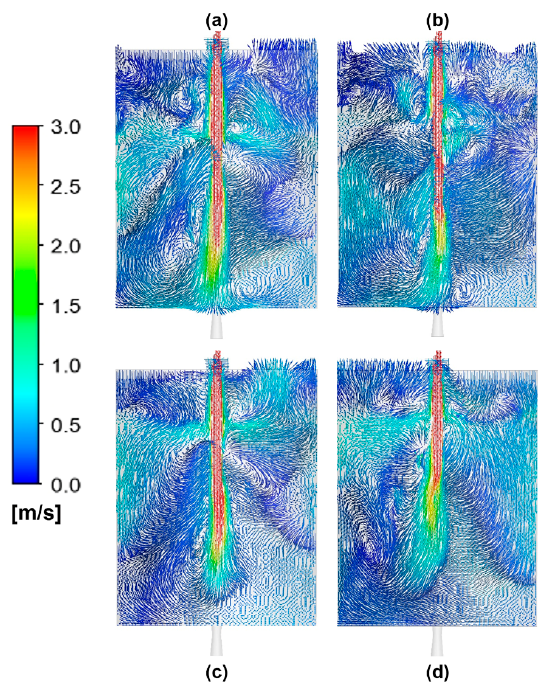
Figure 6. ( a – d ) Unsteady fields of velocity in the central plane during ladle filling from 50 to 80 tons. Each figure shows a time step of 20 s. Sectors W and E yield asymmetric flows as is seen in Figures 7 and 8 for the vertical planes E1, E3, E5, and W1, W3, and W5 and bath levels of 30 and 80 tons, respectively.